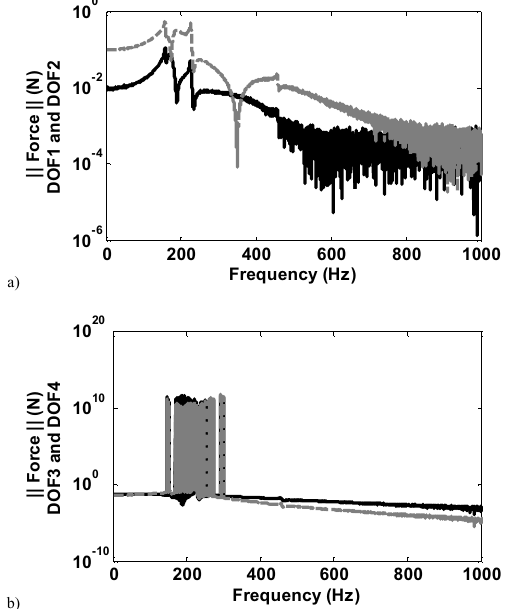
Fig. 5. Force estimates using the amplitude-based technique for a) the first (——) and second (– – –) DOF and b) the third (——) and fourth DOF(– –